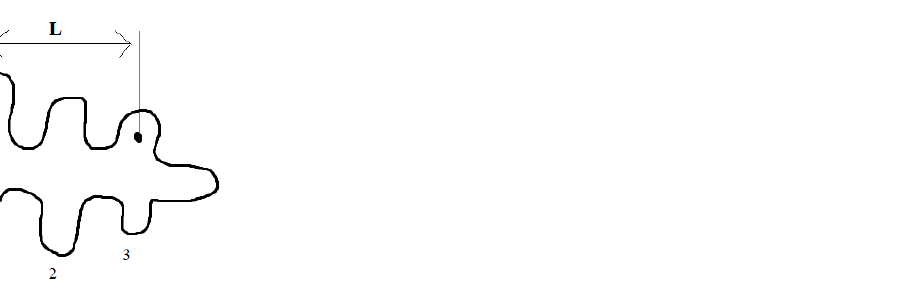
Figure 2. SDAS measurement scheme: L is the distance of secondary arms; 1, 2 and 3 are the axes.